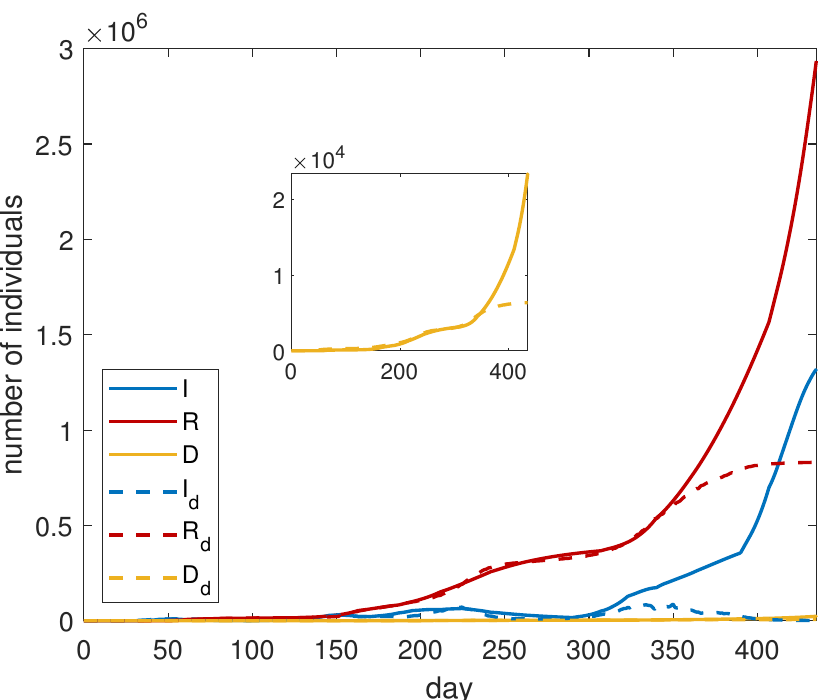
Figure 2. Comparison between SIRD model (3), with parameters of Table 2 (continuous lines), and ISR data (dashed lines). In the inset, the curve of the deaths is